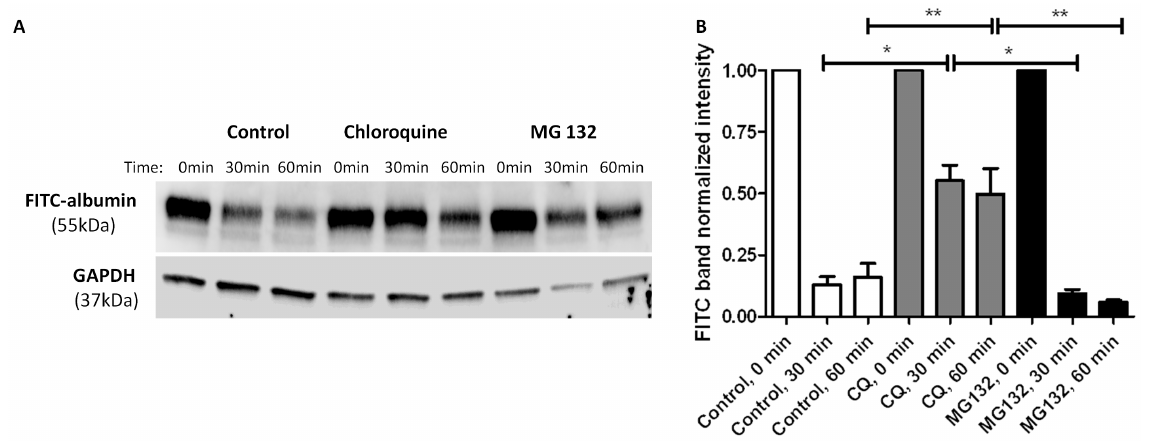
Figure 2. Albumin degradation in podocytes decreased with lysosome inhibition, but not proteasome inhibition. Densitometry and representative Western blot demonstrating albumin degradation. Podocytes were pretreated with standard media (controls, n=7), 50 m M chloroquine (lysosome inhibitor, n=5), or 10 m M MG-132 (proteasome inhibitor, n=4) for 24 h. At 24 h, podocytes were treated with 1.5 mg/mL FITC-albumin for 1 h then washed. Cells were harvested at time zero, 30 min, and 60 min after washing. A ) Albumin abundance in cell lysates was quantified by Western blot analysis using an antibody to FITC. B ) Albumin abundance in chloroquine treated cells was significantly increased compared to control and MG-132 treated cells at 30 min (*p , 0.05) and 60 min (**p , 0.05). Densitometry was normalized to GAPDH and time